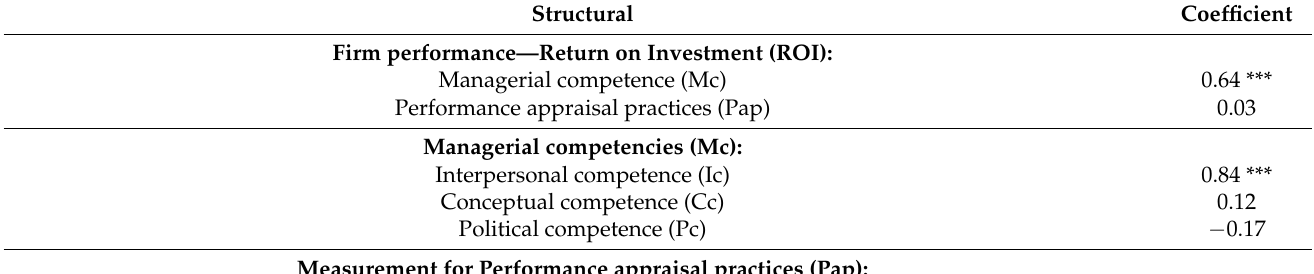
Table 4. Influence of managerial competencies and performance appraisal practices on firm’s ROI. Structural